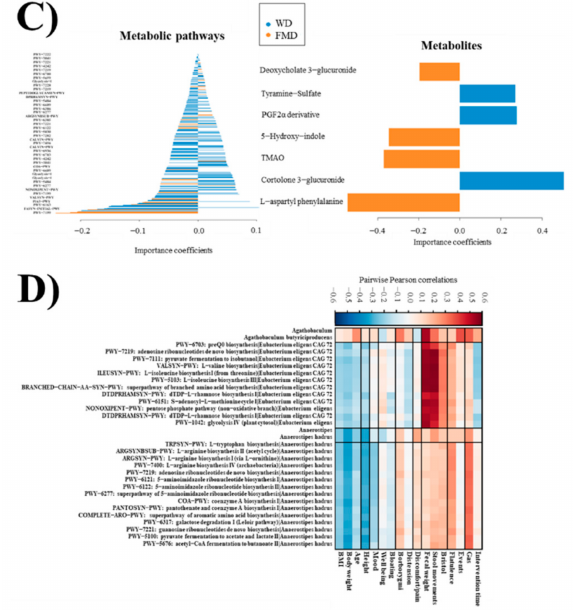
Figure 3. ( A ) Taxonomic clades more abundant in samples after Fibre-Enriched Mediterranean- Type Diet (FMD) intervention. Agathobaculum and Anaerostipes genus as well as Agathobaculum butyriciproducens and Anaerostipes hadrus species showed significantly higher ( p < 0.05) abun- dances, assessed by DESeq2 differential abundance testing, in FMD samples. ( B ) Differential profiles obtained for Western-Type Diet (WD) and FMD samples through multi-omic data integration of metabolic profiles and metabolic pathways determined by shotgun sequencing using DIABLO biomarker discovery pipeline. ( C ) Variable importance coefficients obtained in DIABLO pipeline for metabolites and microbial pathways in WD and FMD interventions. TMAO: